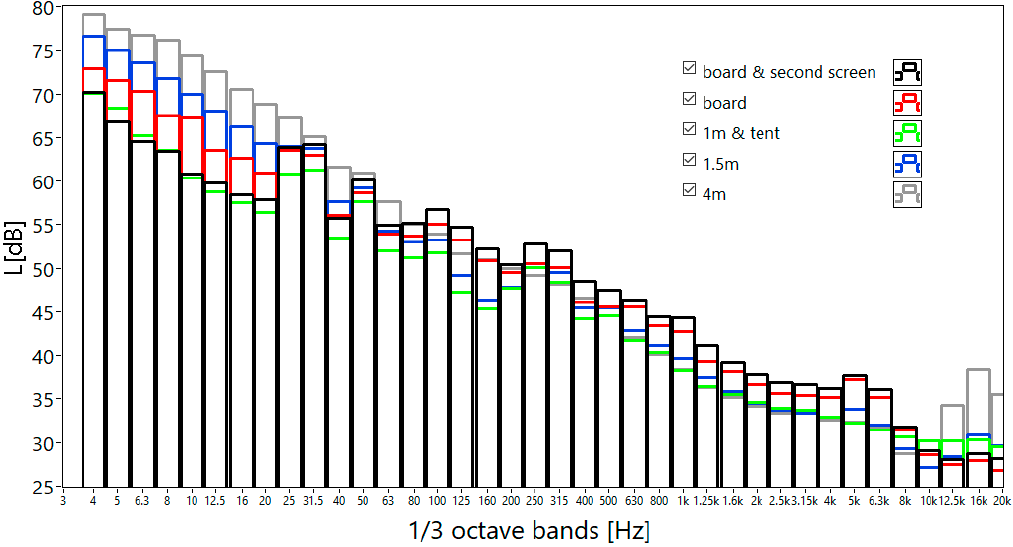
Figure 17. Wind turbine noise. 1/3 octave spectrum, average wind speed—3.5 m/s, max wind speed—6.7 m/s.